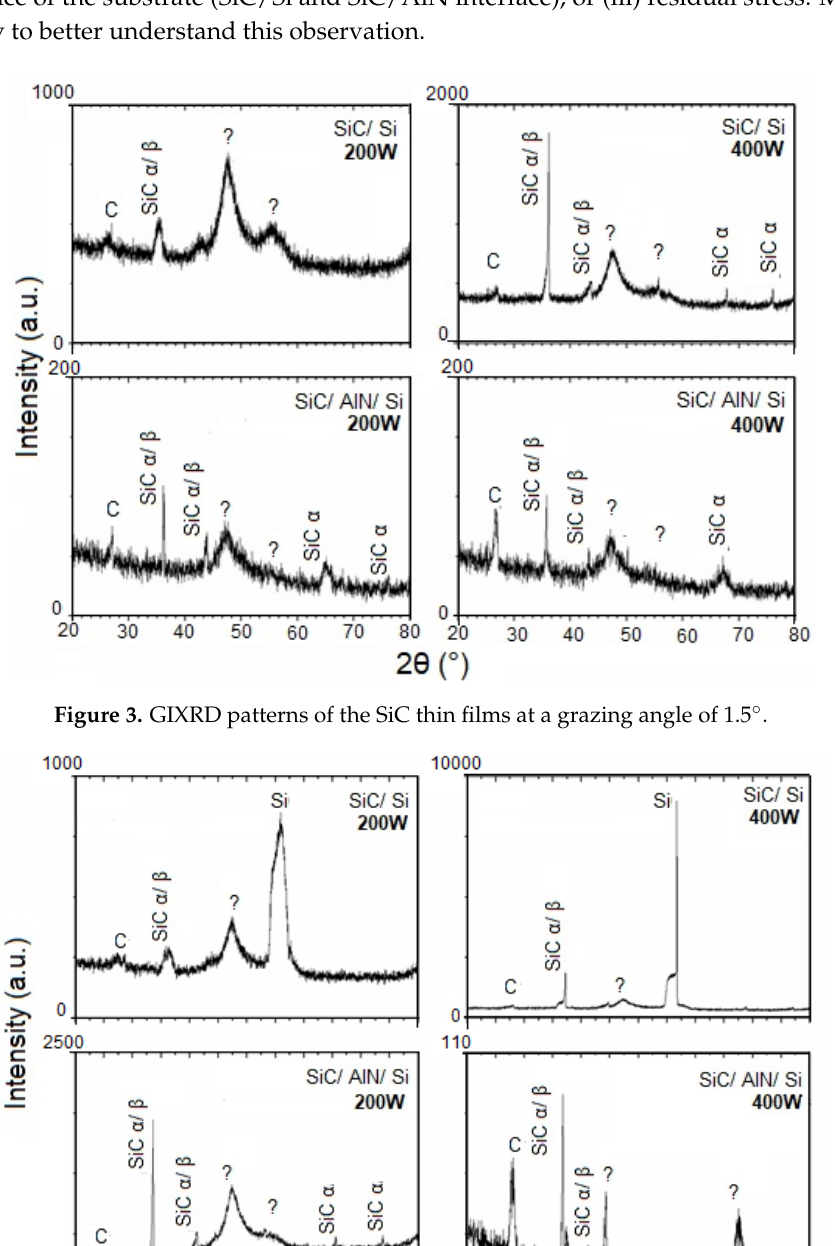
Figure 2. Grazing incidence X-ray diffraction (GIXRD) patterns of the SiC thin films at a grazing angle of 1.0°.